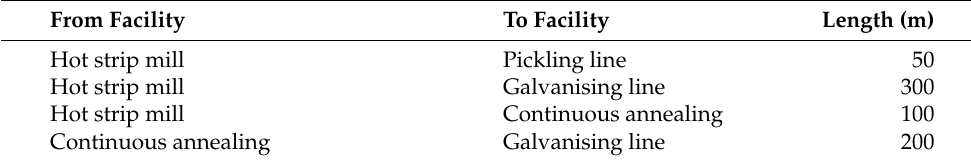
Table 3. Piping length. From